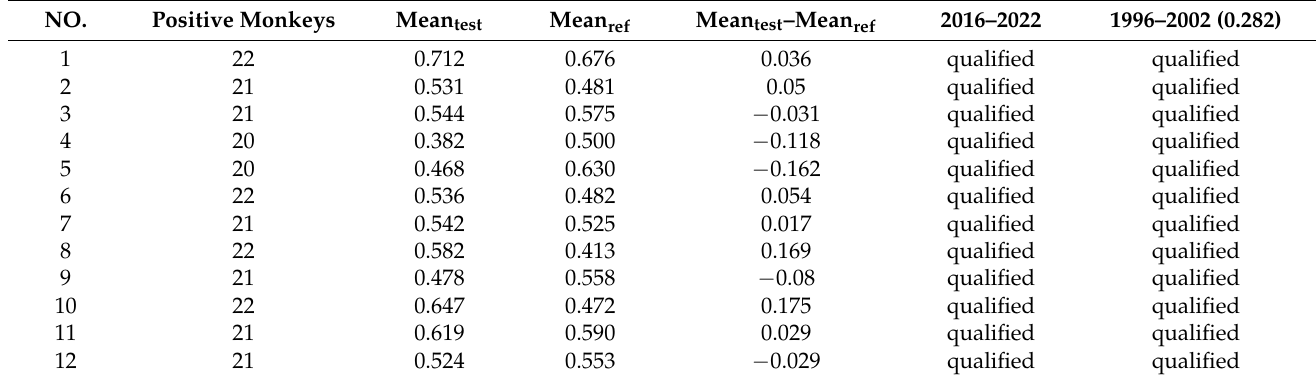
Table 6. The mean value of type III OPV stock solution between 2016 and 2022 and the MNVT qualification under different judgment